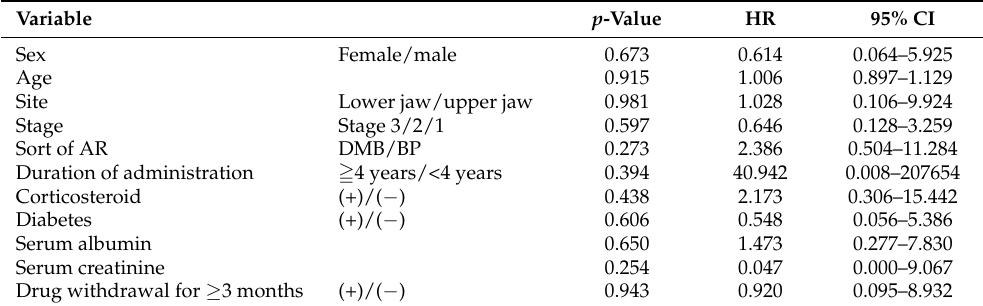
Table 6. Factors related to healing rate of MRONJ by univariate analysis of 27 patients undergoing conservative